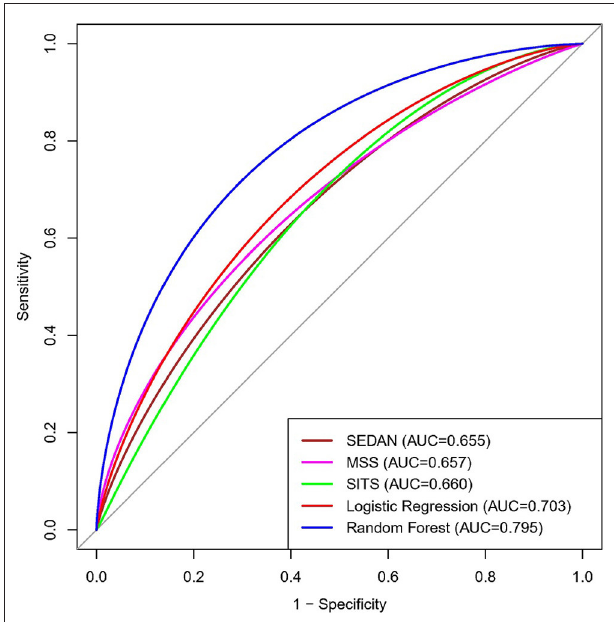
FIGURE 3 | Area under the receiver operating characteristics curves (AUC) for predicting HT in AIS after Intravenous Alteplase. HT, hemorrhage transformation; AIS, acute ischemic stroke.